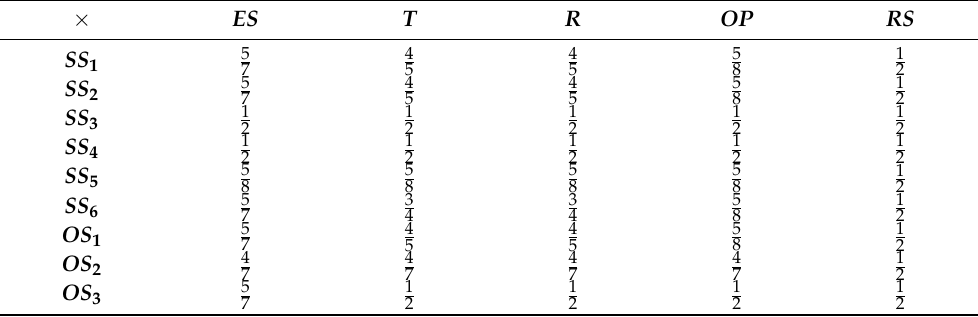
Table 5. Cartesian product S × A in a fuzzy environment. × ES T R OP RS SS 1 5